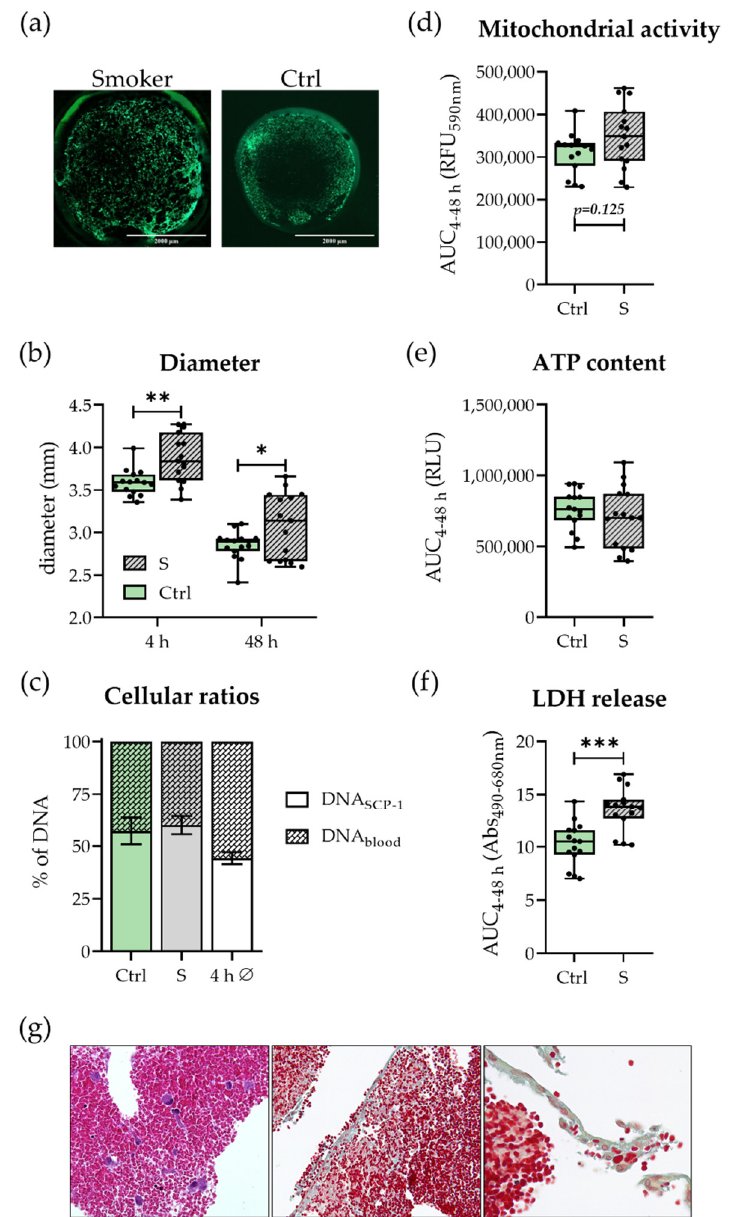
Figure 2. Viability of smokers’ (S) and non-smokers’ (Ctrl) in vitro hematomas. With ( a ) Exemplary life staining images after 48 h in 1.25× magnification. Scale bars refer to 2000 µm. ( b ) Hematoma diameter after 4 and 48 h of incubation. ( c ) Ratio between SCP-1 cells and blood cells determined by sex-specific qPCR after 48 h compared to the average after 4 h (4 h Ø). Data are shown as mean ± SEM. ( d ) Mitochondrial activity determined by Resazurin conversion. ( e ) ATP content in the hematomas. ( f ) LDH release into the culture supernatant. ( d – f ) are all represented as Area Under the Curve (AUC) over the entire cultivation period of 48 h. ( g ) Representative microphotographs from formaldehyde-fixed, paraffin-embedded in vitro hematomas: left image (non-smoker, hematoxylin-eosin), highlighted SCP-1 cells (arrow); center/right image (smoker, Movat pentachrome), erythrocytes, and fibrin, higher magnification in right image shows spindle cell differentiation of SCP-1 cells. Images were recorded in 200× (left and center) and 400× (right image) magnification. Experiments were performed in N = 5, n = 3. * p < 0.05, ** p < 0.01, *** p < 0.001.